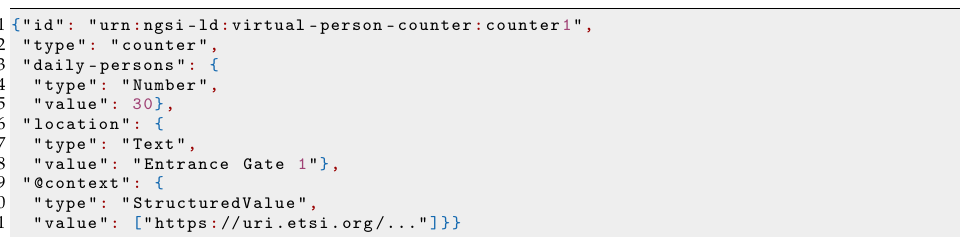
Table 4. Context data from Table 1 translated to NGSIv2.